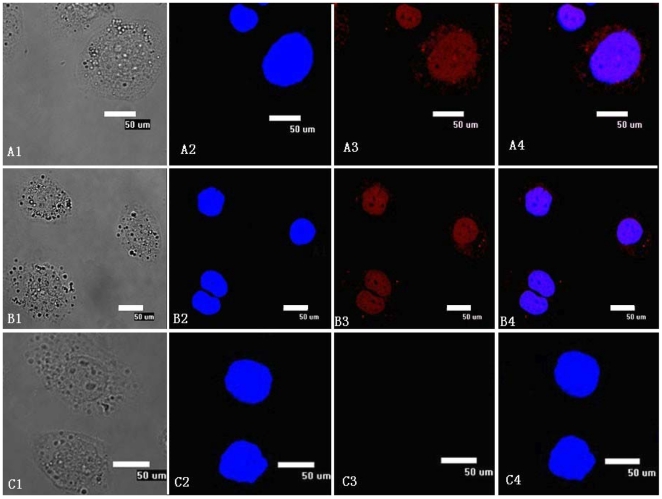
Subcellular localization of BmTHY in Bm5 cells by immunofluorescence.A1–A4,B1–B4: Experimental group, using anti-BmTHY polyclonal antibody;C1-C4: negative control group, using negative rabbit serum;A1,B1,C1: Cells under transmitted light. A2,B2,C2: DAPI staining;A3,B3,C3: BmTHY subcellular localization as indicated by Cy3-labeled secondary antibody;A4,B4,C4: merged image.